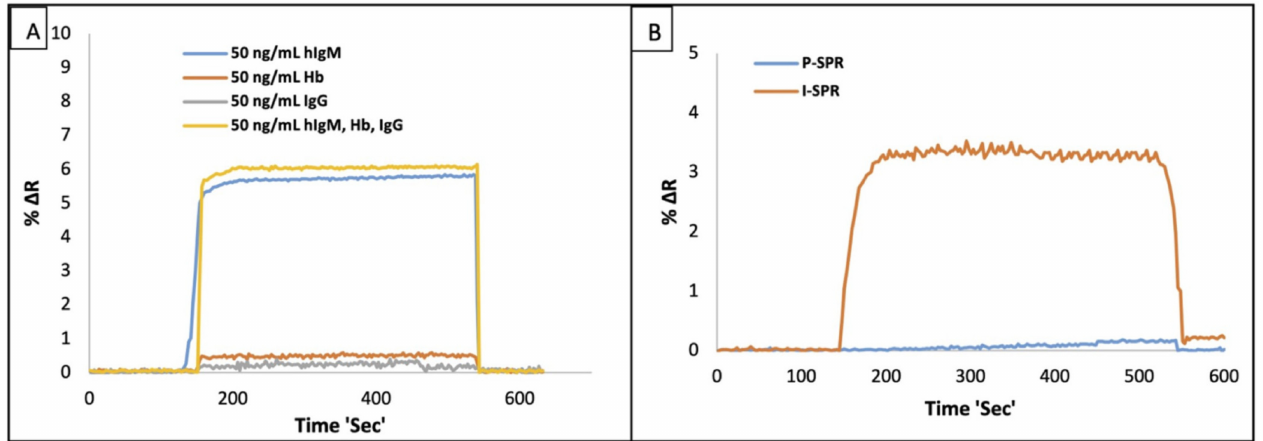
Figure 4. The selectivity of the I-SPR sensor ( A ) towards IgG and Hb molecules (concentration of the competitor molecules 50 ng/mL, pH: 7.4., flow rate: 150 µ L/min and T: 25 ◦ C) and the comparison results of I-SPR and P-SPR ( B ) in the aqueous solution (IgM concentration: 10 ng/mL, pH: 7.4., flow rate: 150 µ L/min and T: 25 ◦